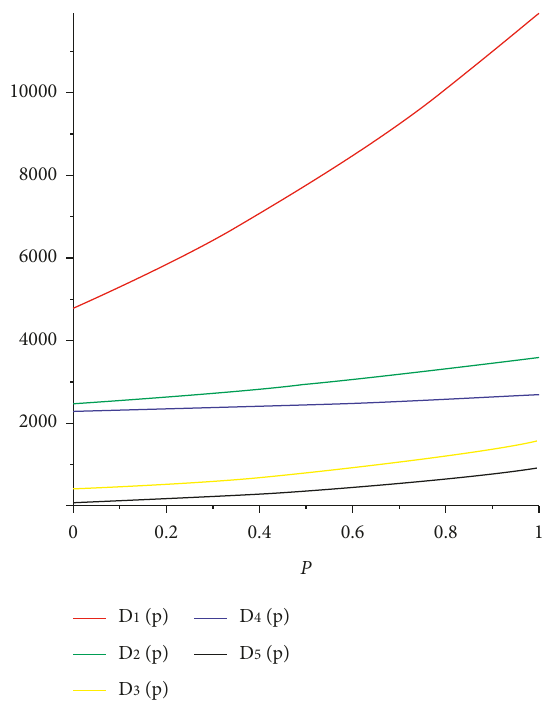
Figure 9: Comparison of KBR